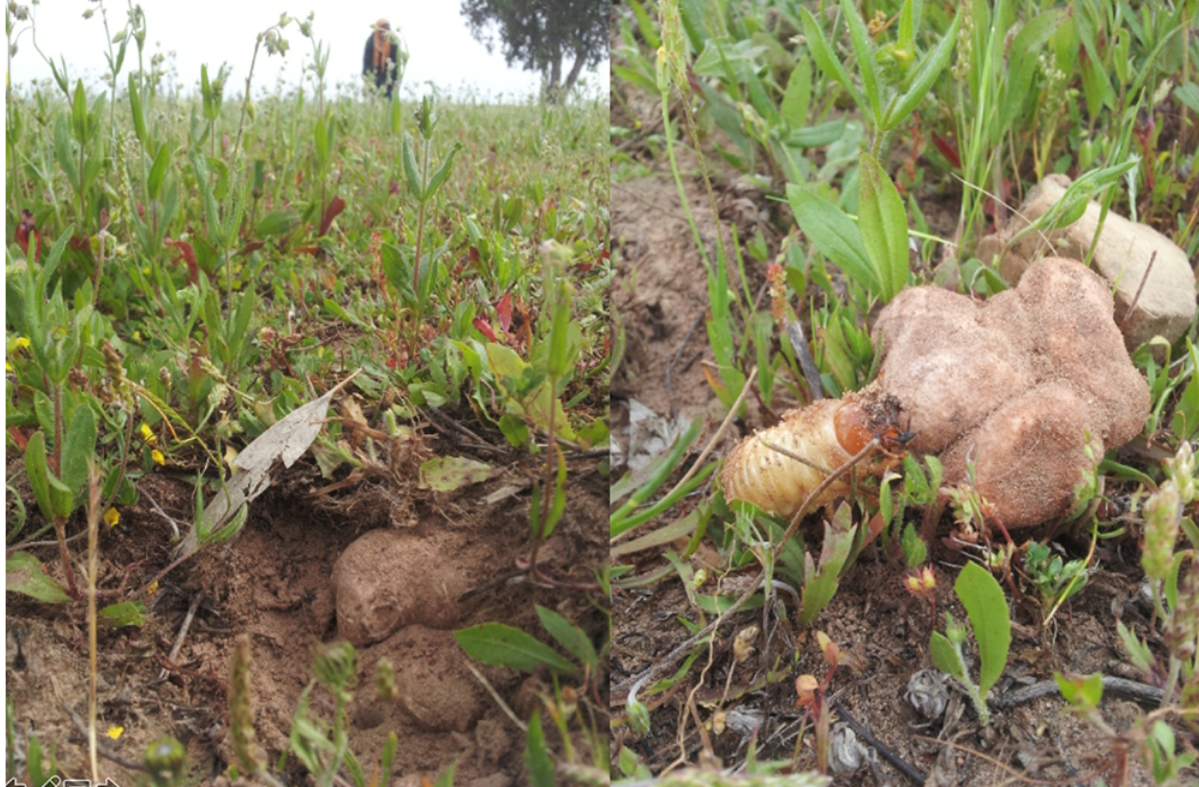
Fig. 3 Desert truffle ( Terfezia arenaria ) in the soil (left) in Morocco and an example of larvae (unidentified) that are occasionally found in close proximity to the fruiting body (right). Note: these larvae do not seem to damage the truffle, but may benefit from the locally elevated moisture levels. The photographs were taken by the corresponding